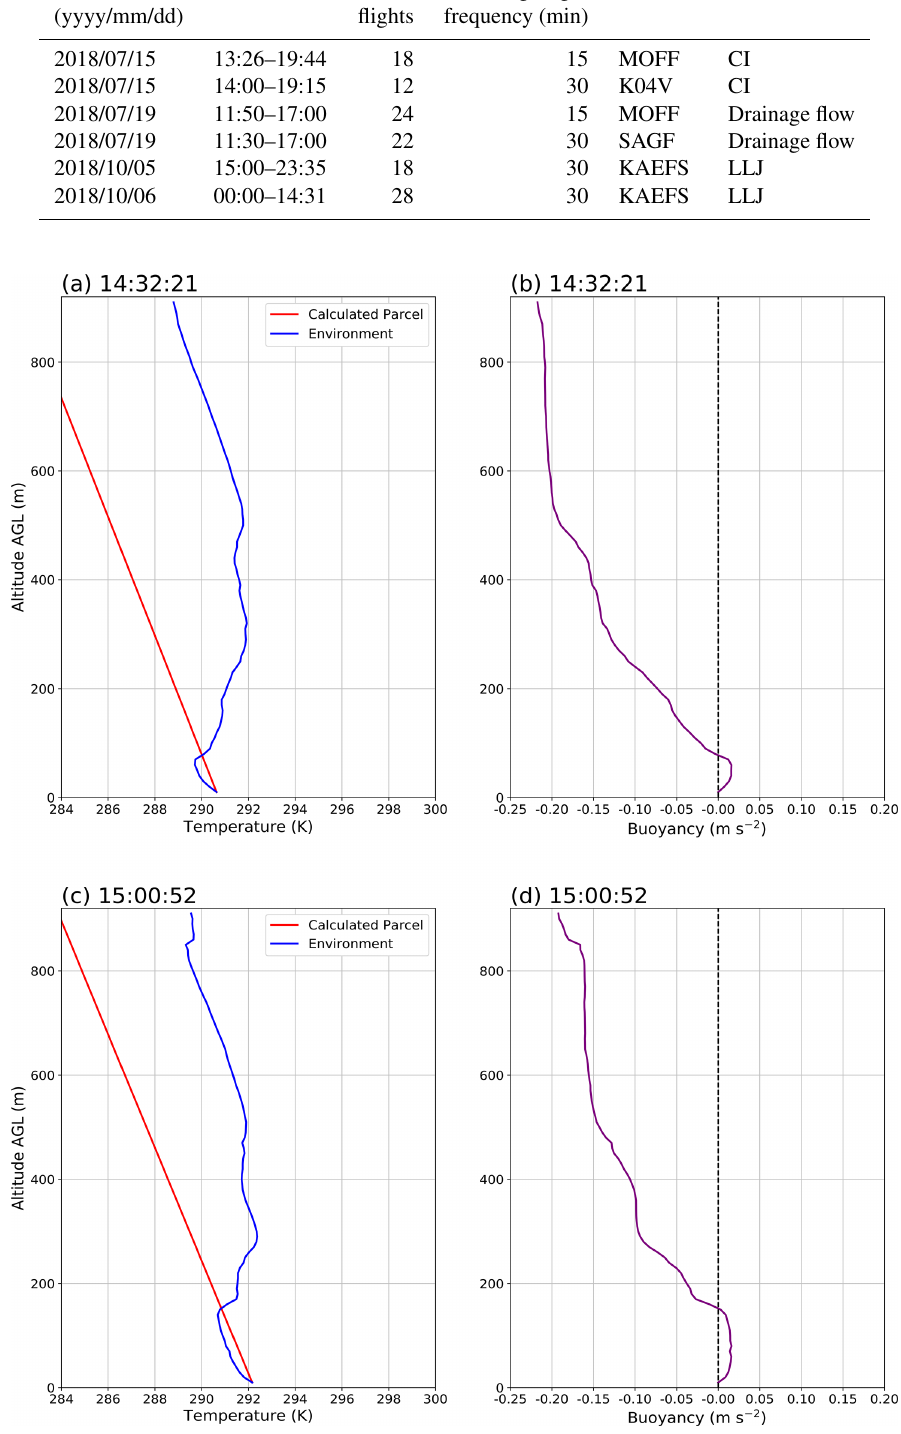
Figure 1. Temperature (K) and buoyancy (ms − 2 ) profiles from CopterSonde at MOFF on 19 July 2018. (a, c) Temperature observed from CopterSonde (blue) and the dry adiabatically lifted parcel (red). (b, d) Buoyancy profile (purple) shown with the black dashed line at neutral (zero) buoyancy. All times are in